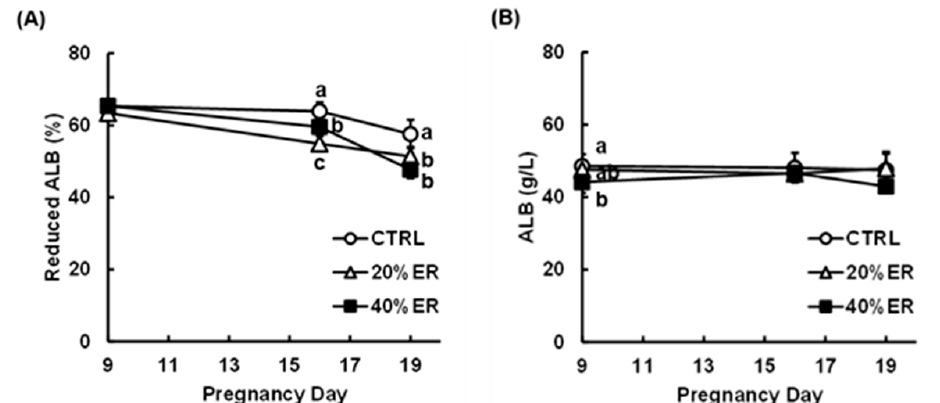
Figure 3. Serum reduced albumin (ALB) ratio and serum ALB concentration in pregnant rats. Serum samples of pregnant rats, obtained on pregnancy day 9 (PD9), 16, and 19, were applied to the analyses of reduced ALB ratio ( A ) and ALB concentration ( B ). Data are expressed as means ± SDs ( n = 6), which were analyzed by one-way ANOVA followed by a Tukey–Kramer HSD test; at each time point, values with different letters are significantly different ( p < 0.05). CTRL, control; 20% ER, 20%